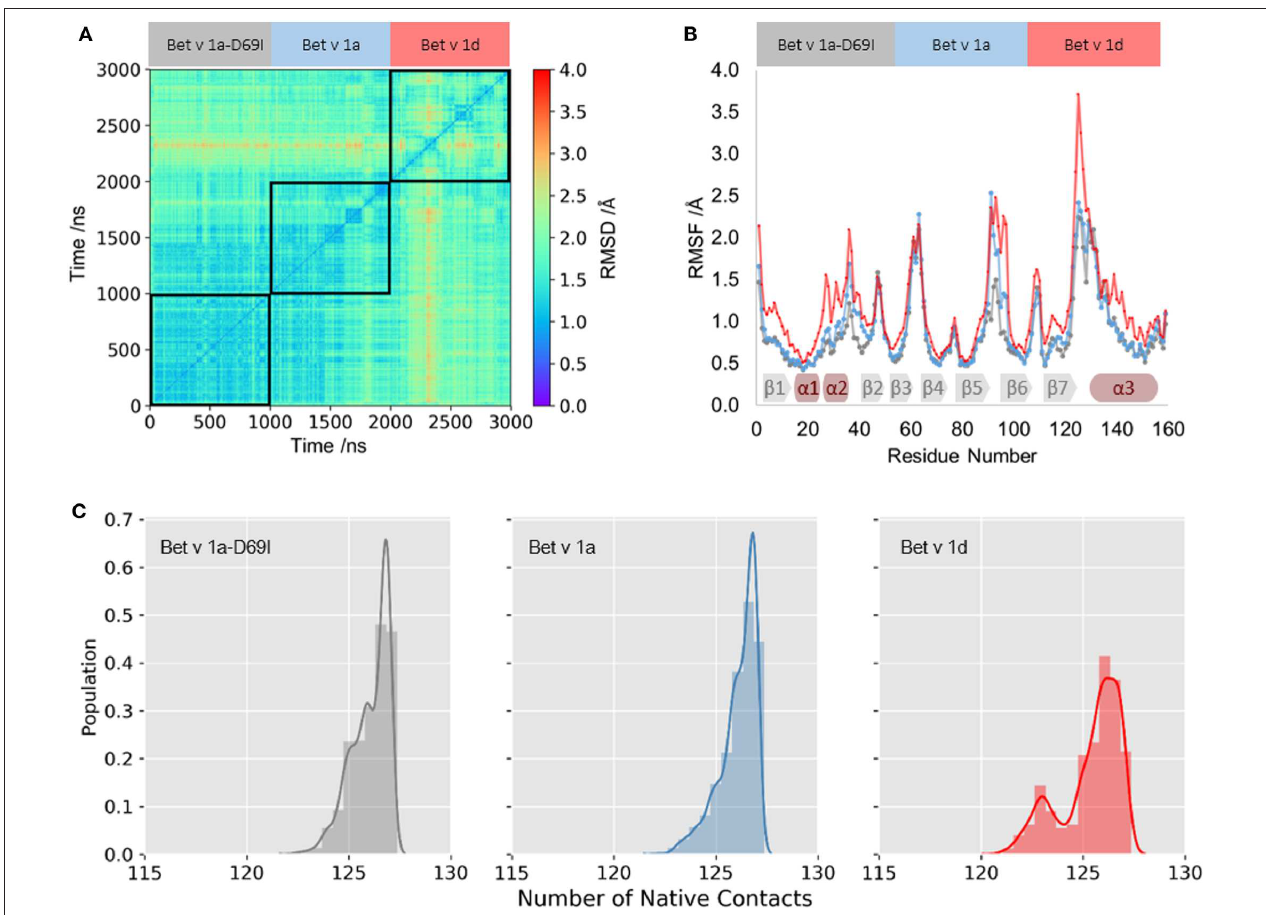
FIGURE 1 | Fold dynamics of Bet v 1 variants. (A) The conformational space captured in 1 µ s cMD simulations of the stabilized variant Bet v 1a-D69I , wild-type protein Bet v 1a and the destabilized variant Bet v 1d , respectively, was profiled via a 2D-RMSD analysis based on all C α atoms. (B) To quantify the local differences in flexibilities we calculate the RMSF for each residue based all C α atoms. The secondary structure elements found in the crystal structure are depicted on the bottom. (C) From the distribution of native contacts between backbone N and O atoms of helix1 and helix2 we calculate entropies as a measure of backbone